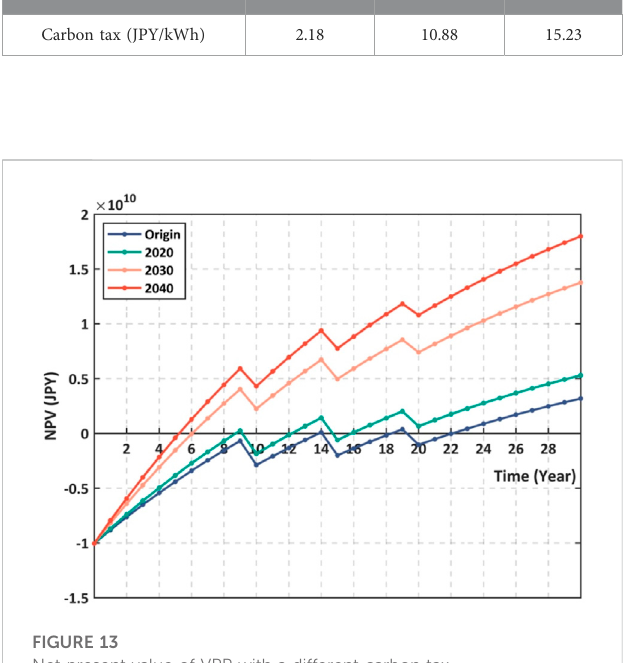
FIGURE 13 Net present value of VPP with a different carbon